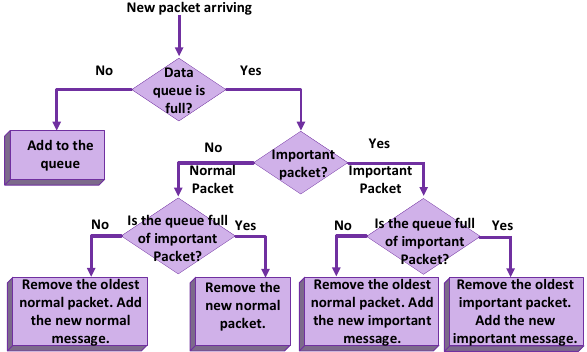
Figure 33. Data scheduling for backscatter